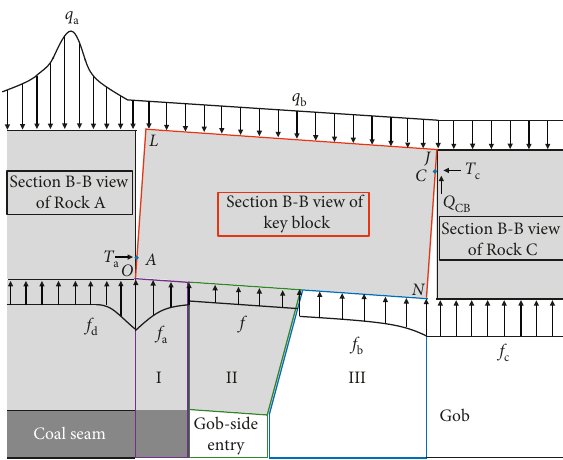
Figure 6: Simplified diagram of the stress on the key